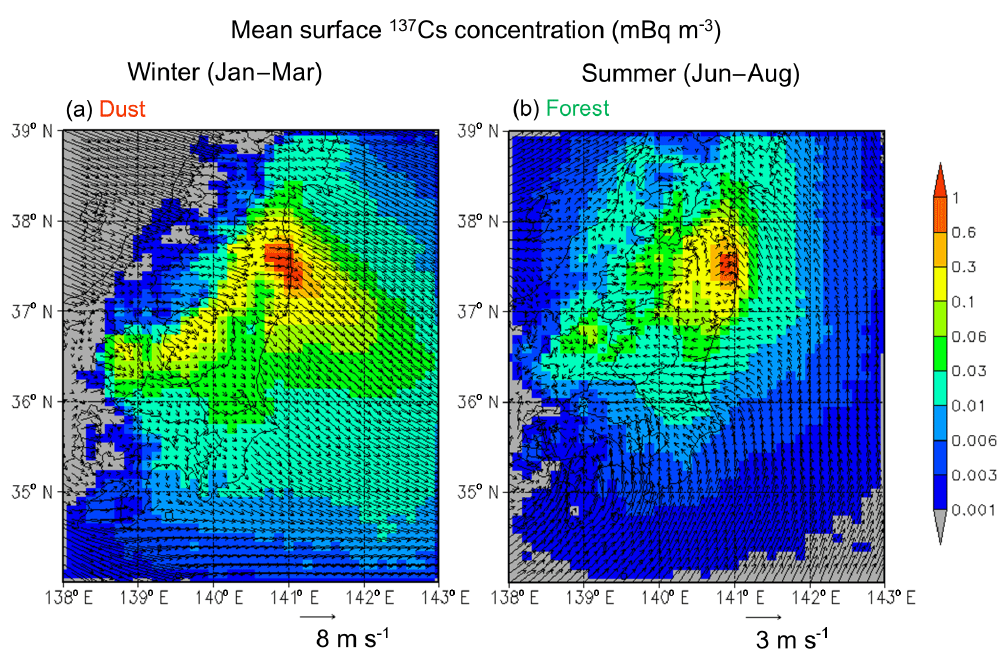
Figure 10. Seasonal mean surface (10m above ground level) wind vector and 137 Cs surface concentration (a) due to dust re-suspension in winter from January to March and (b) due to forest re-suspension in summer from June to August. The deposition parameters of the simulation in the figure are E c = 0.04 and v d = 0.1cms − 1